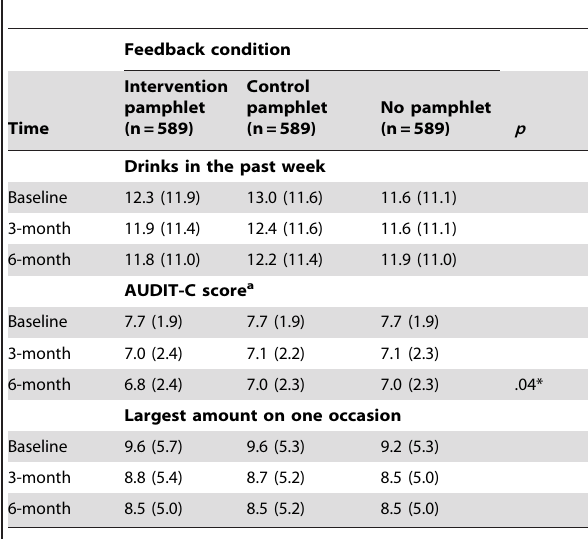
Table 1. Mean ( SD ) drinking variables at baseline, three-, and six-month follow-up by study